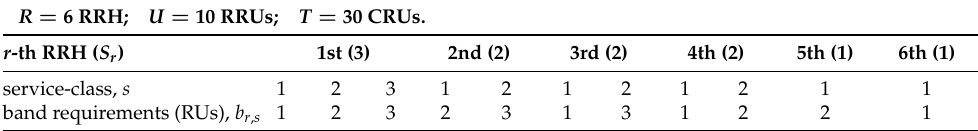
Table 1. The setup of the C-RAN